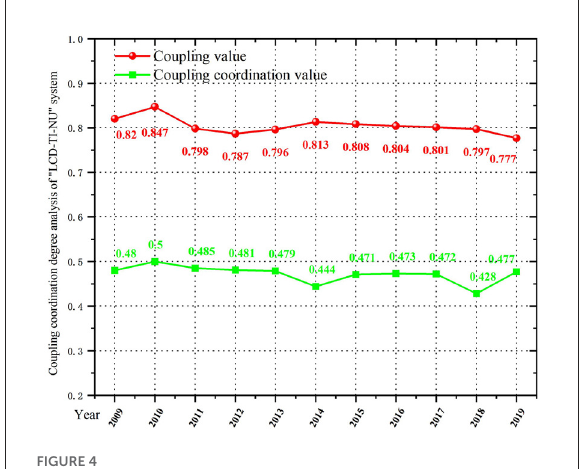
FIGURE4 Coupling coordination degree analysis of “LCD-TI-NU” system in China, 2009–2019.